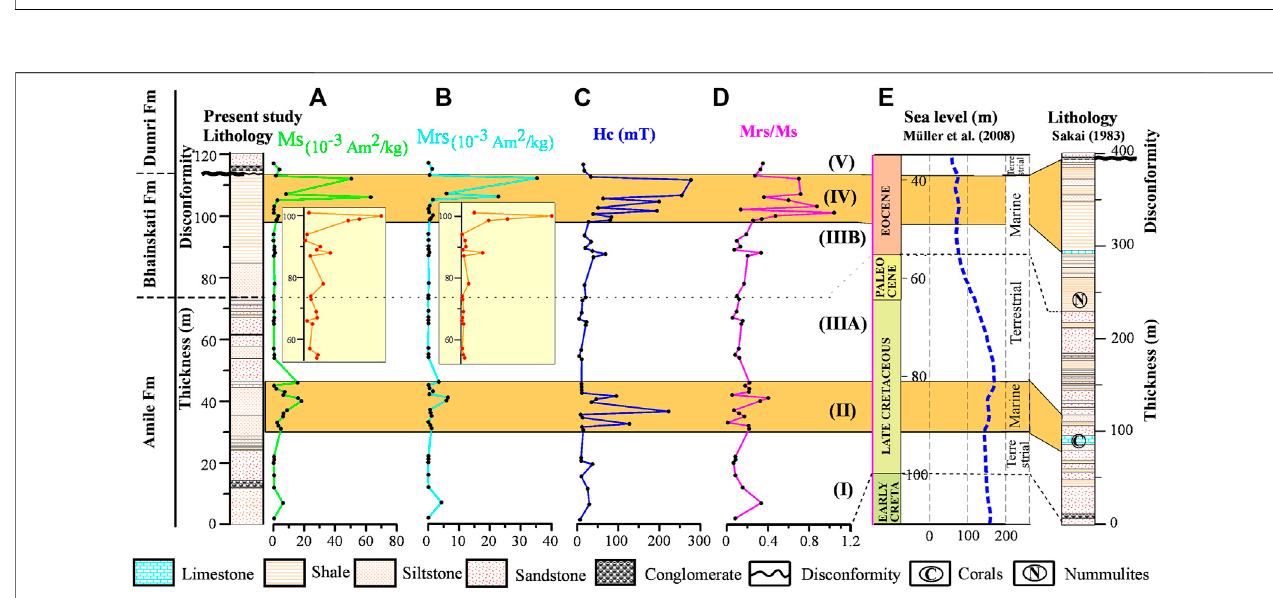
FIGURE 4 | Lithology and hysteresis parameters (Ms, Mrs, Hc and Mrs/Ms) variations of the late Cretaceous to middle Eocene strata in the Palpa section. The samples within the marine regime show greater peaks of hysteresis parameters as compared to the terrestrial regime. The change in sea level condition may have affected the development of these